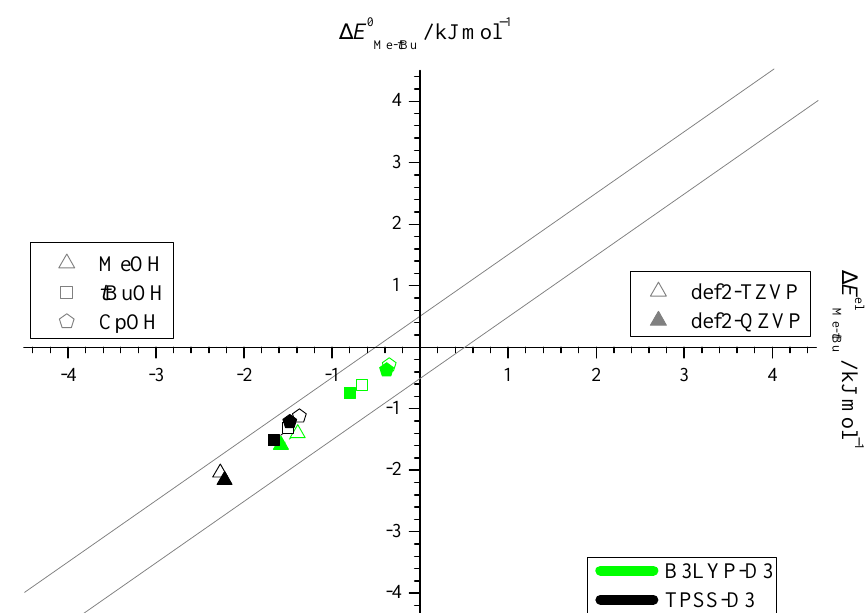
Figure 2. Harmonically zero-point corrected energy differences ∆ E 0 plotted against the electronic Me − t Bu energy differences ∆ E el referenced to the t Bu side, computed at B3LYP-D3 (green) and TPSS-D3 Me − t Bu (black) level, each with a def2-TZVP (empty symbols) and def2-QZVP (filled symbols) basis set. The electronic energy differences are seen to be a good approximation to experimentally relevant ZPVE-inclusive differences and the methyl docking side is systematically preferred (see also Table